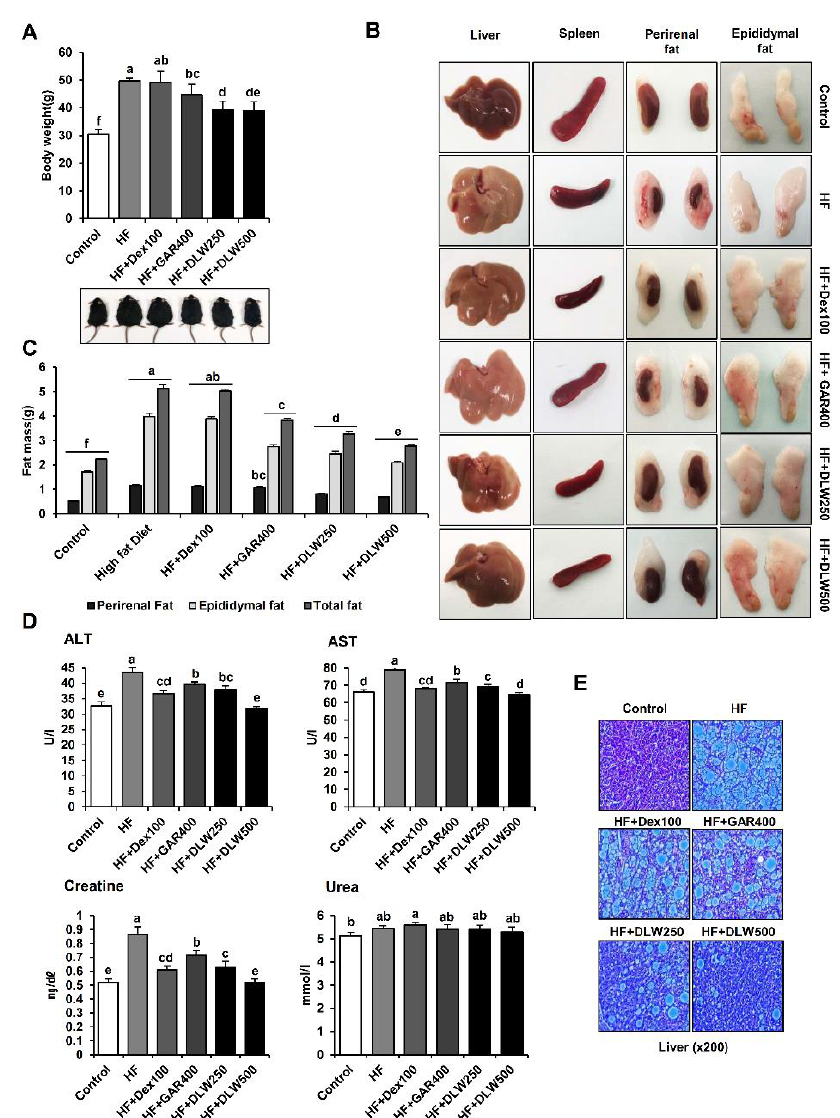
Figure 2. In vivo toxicity of D. morbifera water extract in mice with high-fat diet-induced obesity. DLW extract did not show short-term or long-term toxicity in mice. ( A ) Body weight changes in the control, HF (high-fat), HF+Dex100 (high-fat + Dextrin 100 mg/kg), HF+GAR400 (high-fat + Garcinia 400 mg/kg), DLW250 (high-fat + DLW 250 mg/kg), and DLW500 (high-fat + DLW 500 mg/kg) groups. ( B ) Representative images of the liver, spleen, epididymal fat, and perirenal fat in each mouse group. ( C ) Measurement of the liver epididymal and perirenal fat mass. The HF, HF+Dex100, HF+GAR400, HF+DLW250, and HF+DLW500 groups were treated for 12 weeks. Values for the liver epididymal and perirenal fat mass are shown as the mean ± SEM (n = 6/group, right panel). ( D ) Toxicity and liver damage in mouse serum. The enzymatic activities (U/L, mg/dL, and nmol/L) are shown for various organs in mice administered DLW (250 and 500 mg/kg body weight) or water as a control. ALT, AST, creatinine, and urea levels were measured in the plasma of mice fed HF, HF+Dex100, HF+GAR400, or HF+DLW (250 and 500 mg/kg body weight). ( E ) After 12 weeks of DLW250 and DLW500 treatment, Histological findings of the liver tissue, hematoxylin and eosin staining of mouse liver specimens was carried out. Representative images are shown. Magnification × 200. Control, fed standard as control; HF, fed high-fat diet; HF+Dex100, fed high-fat diet in conjunction with Dextrin 100 mg/kg; HF+GAR400, fed high-fat diet in conjunction with Garcinia 400 mg/kg; HF+DLW250, fed high-fat diet in conjunction with D. morbifera leaf water extracts 250 mg/kg; HF+DLW500, fed high-fat diet in conjunction with D. morbifera leaf water extracts 500 mg/kg. The values presented are the means ± SD of three independent experiments. Means with different superscript letters are significantly different, p < 0.05 (one-way analysis of variance ANOVA followed by Tukey’s multiple